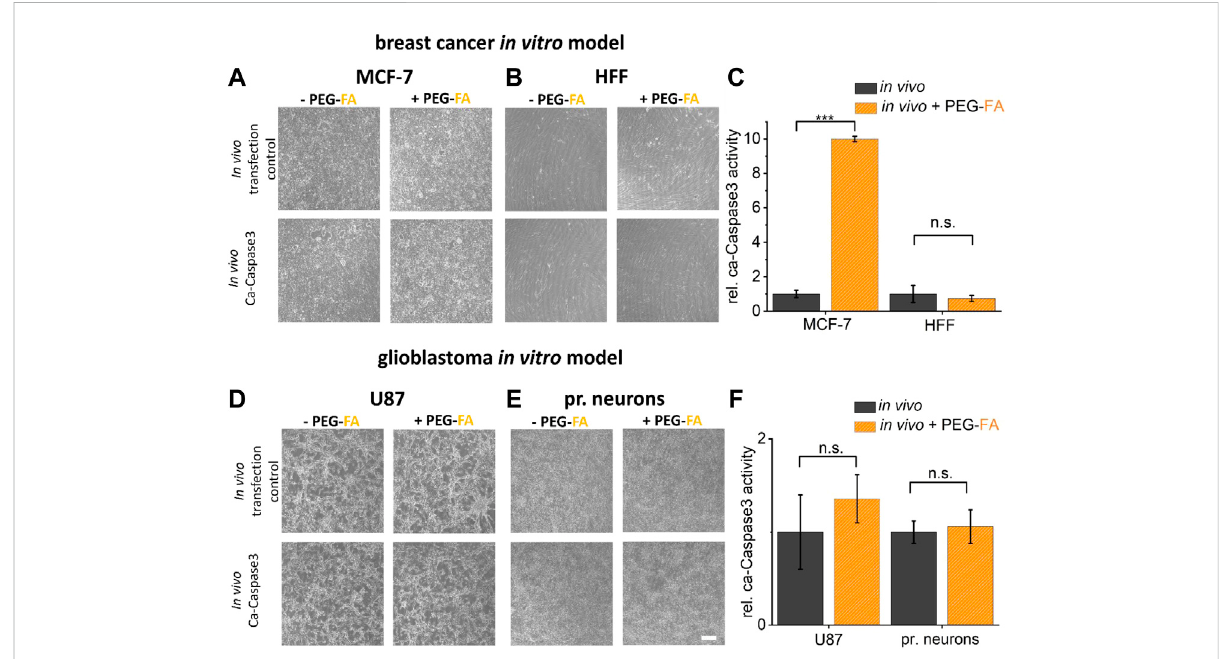
Therapeutic potential characterization by in vitro assays. To investigate the therapeutic potential of the functionalization developed here, a ca- Caspase3 was transferred using FA-functionalized lipoplexes ( (A), (B) fusion/ (D), (E) lipofection). Quanti fi cation of ca-Caspase3 activity in target and non-target cells is shown in (C) and (F) . Scale bar 200 μ m. n = at least three independent